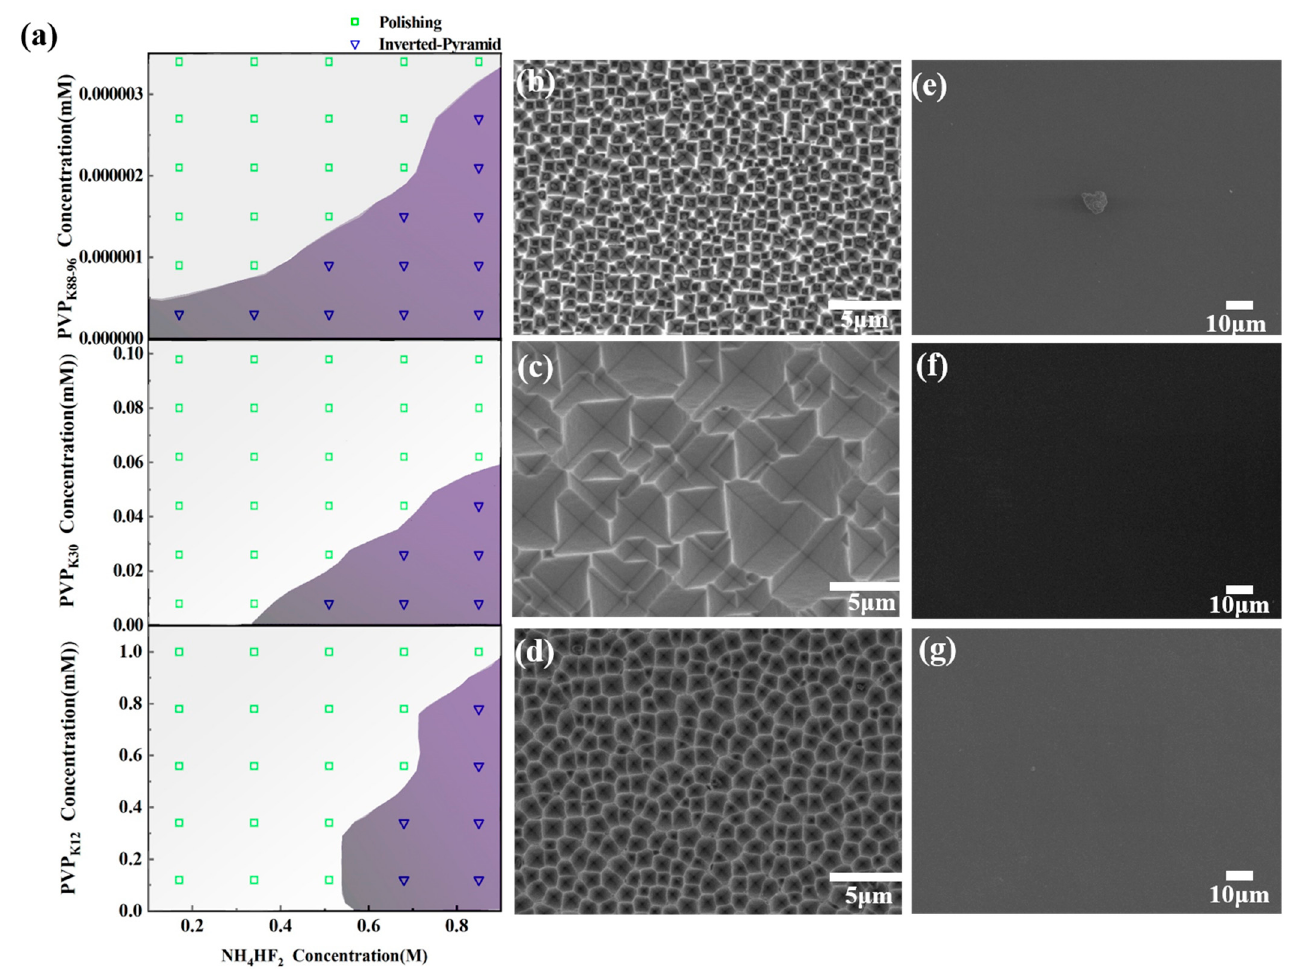
Figure 2. Dependence of the etching results ( a ) on NH 4 HF 2 and PVP concentration and SEM images of inverted pyramid fabricated by Ag@PVP–ACE ( b – d ) and polished Si surface after treatment with Ag@PVP–ACE solution ( e – g ). The above samples were etched in mixed solution with 94 mM AgNO 3 and 0.9 M H 2 O 2 for 20 min at 65 °C.